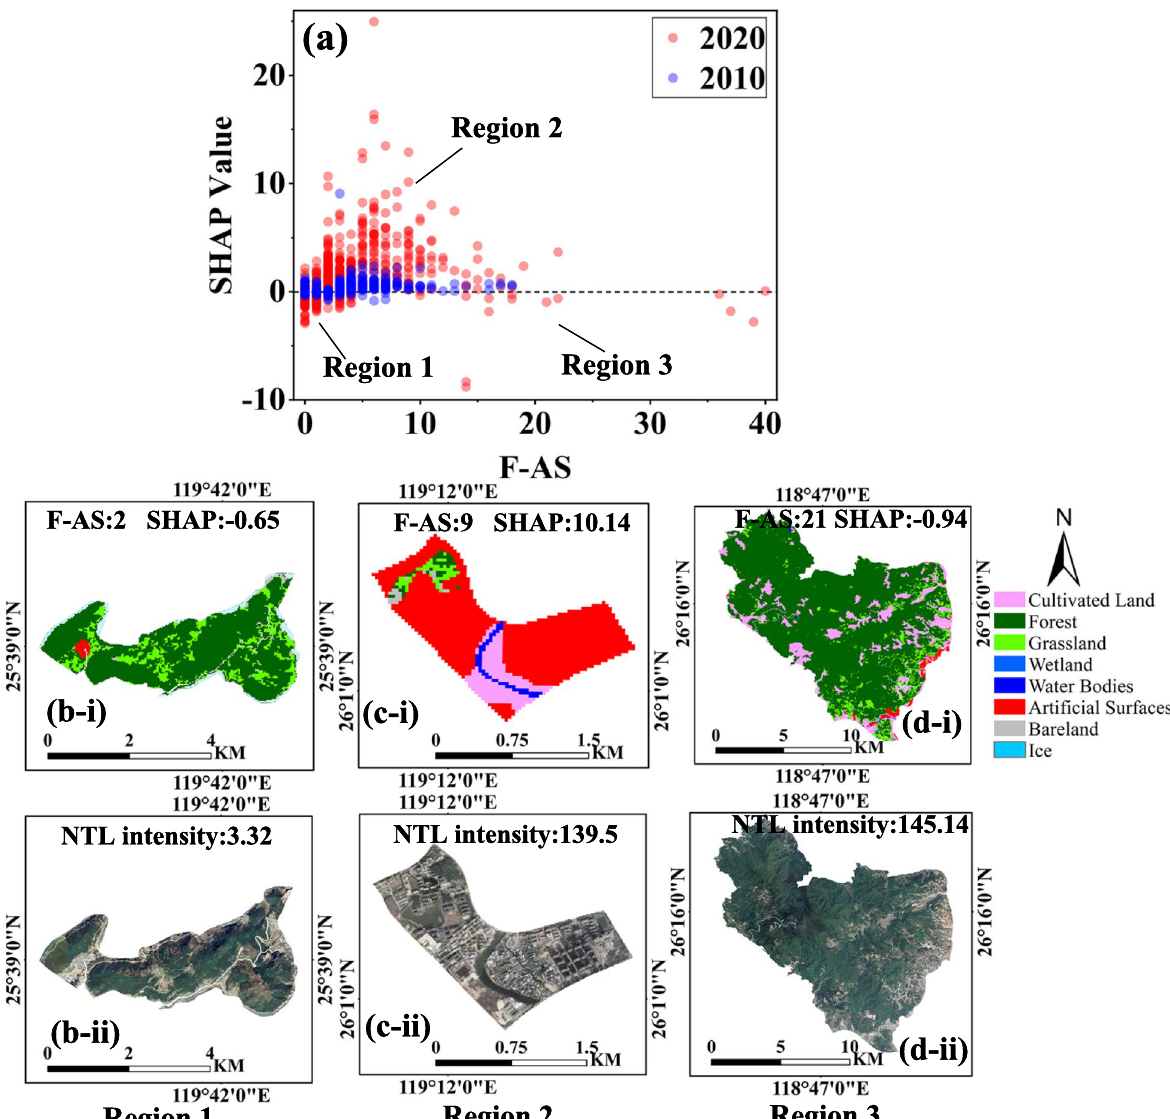
Fig. 8 Sample parcels and SHAP dependency plot of ( a ) F-AS in 2010 and 2020 and ( b‑d ) three sample parcels’(i) land cover maps and (ii) remote sensing